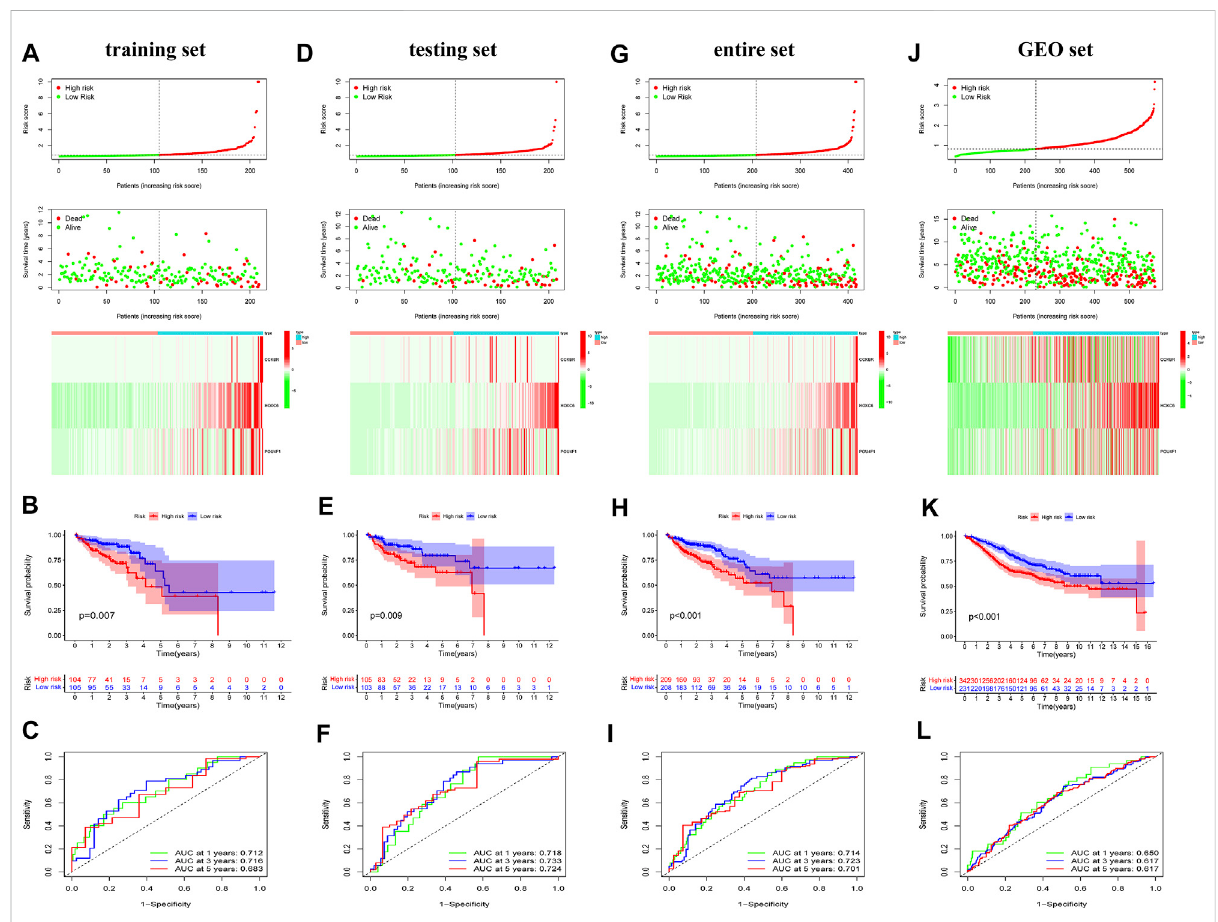
FIGURE 2 Identi fi cation and validation of the exosome-related genes signature. Risk scores for all patients in each cohort are listed in ascending order, withthemedianasthethreshold,COADpatientsweredividedinlow-risk(green)andhighrisk(red).Therankeddotplotillustratedthedistributionof survival status and the heatmap showed the expression pro fi les of 3 ERGs in the training set (A) , testing set (D) , entire set (G) and GEO set (J) . Kapan- Meier survival curves analyses and ROC analysis in predicting prognoses in the training set (B,C) , testing set (E,F) , entire set (H,I) and GEO set (K,L)